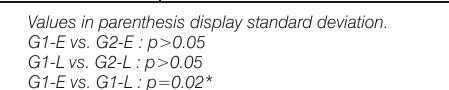
* Significant difference within the same subgroup (p<0.05). § Significant difference between two subgroups (p<0.01).